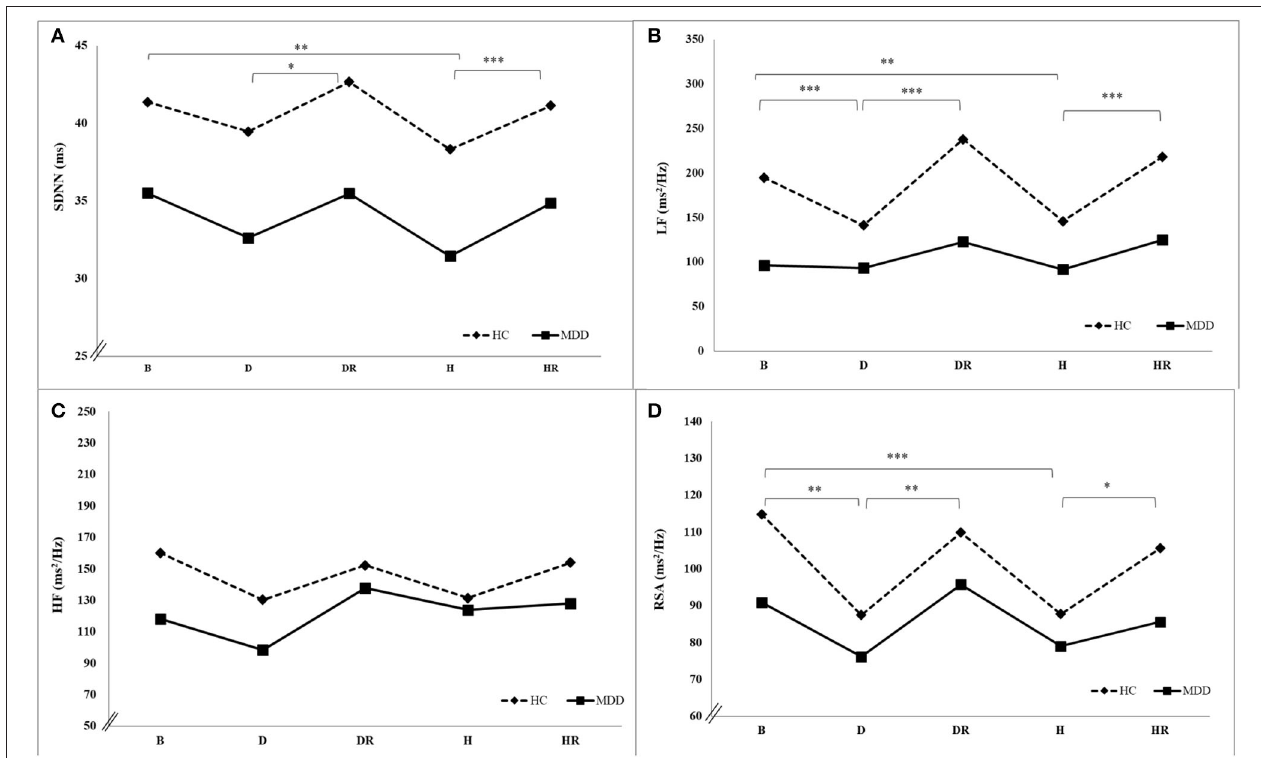
FIGURE 2 | HRV (A–C) and CVC (D) indices under depressive and happiness autobiographical memories for the MDD and HC groups. B, baseline; D, depressive autobiographical memory; DR, depressive recovery; H, happiness autobiographical memory; HR, happiness recovery.